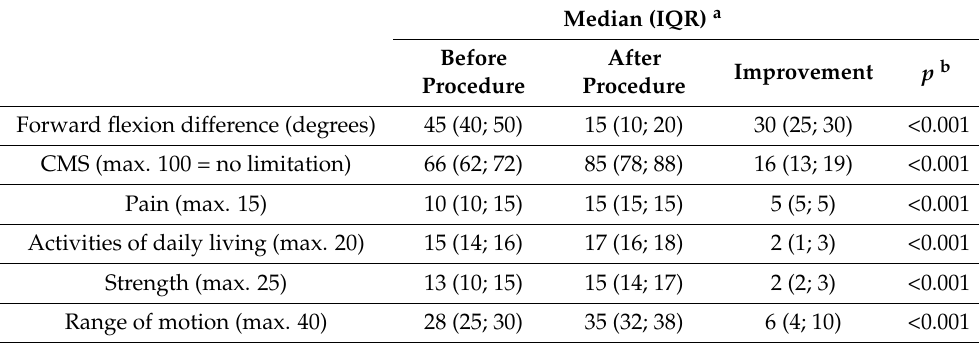
Table 2. Group characteristics, overall outcomes of the treatment and effects of treatment on individual components of the Constant–Murley score.